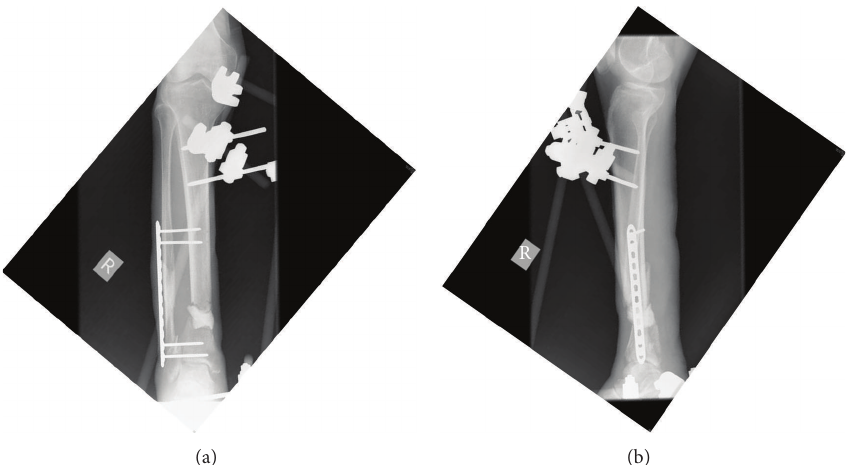
Figure 2: AP (a) and lateral (b) radiographs showing fixation with external fixator and screws and placement of antibiotic cement spacer into the defect after the wound had been adequately